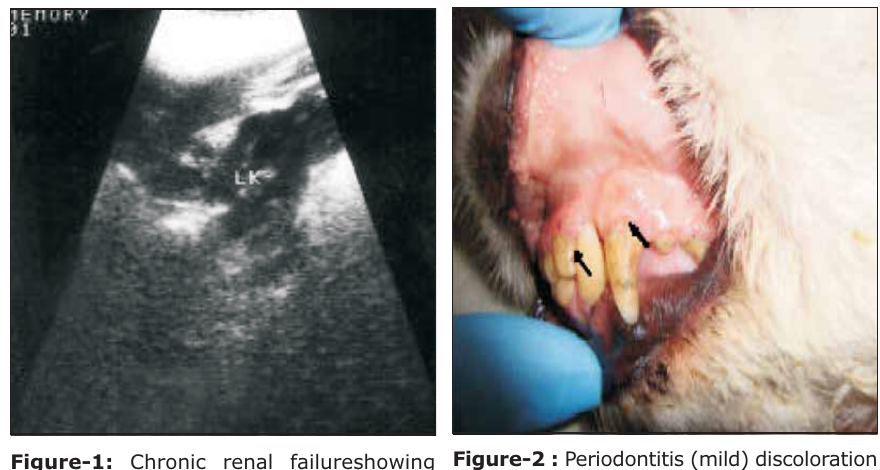
Figure-2 : Periodontitis (mild) discoloration Figure-1: Chronic renal failureshowing ofdentalenamelwithlossofgingival loss of cortico-medullary definition. Table-1: Comparison of periodontal complications among dogs with renal dysfunction and dogs with normal renal function. Variable